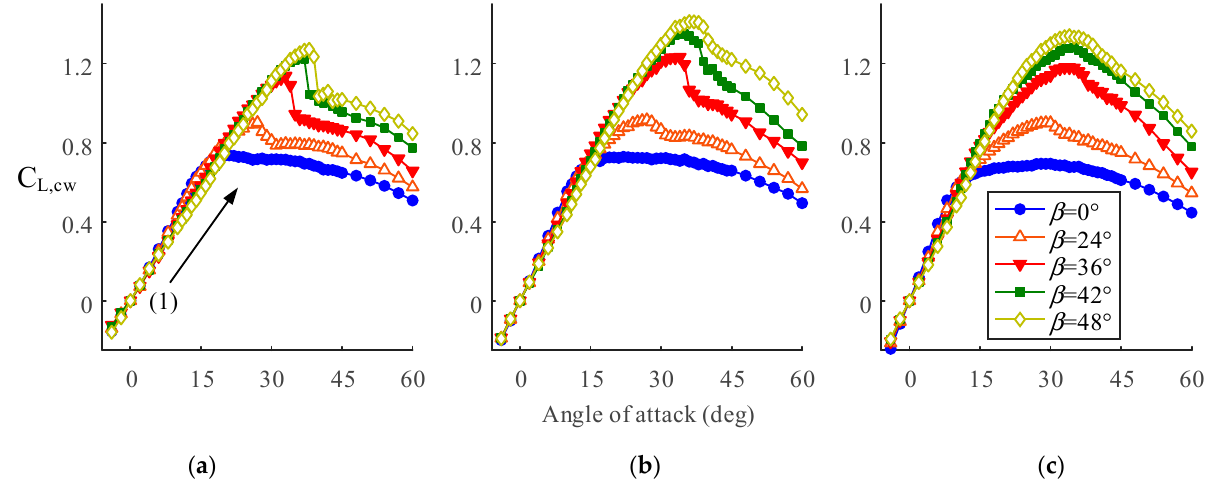
Figure 7. Lift coefficients based on the chordwise component of the freestream C L,cw . ( a ) AR = 2.03; ( b ) AR = 3.13; ( c ) AR = 4.50.